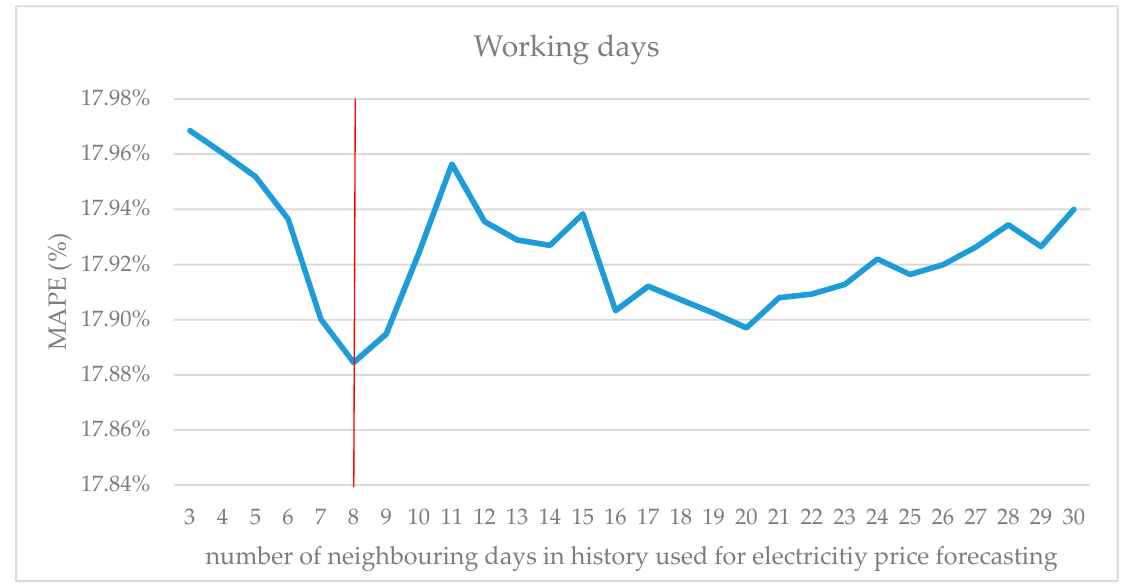
Figure 10. Correlation between price forecasting error and the size of a similar day data set for working days.